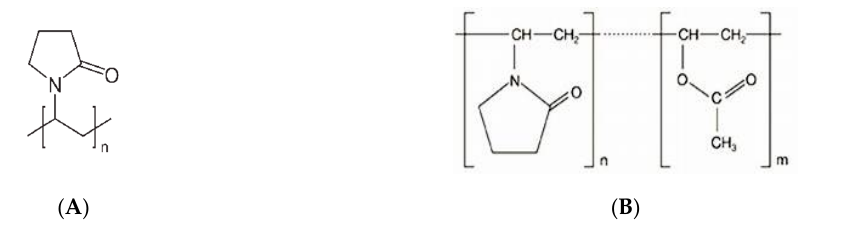
Figure 5. Chemical structure of water-soluble polyvidone (PVP) (povidone; ( A )) and water-insoluble PVP vinyl acetate copolymer (copovidone; ( B )).